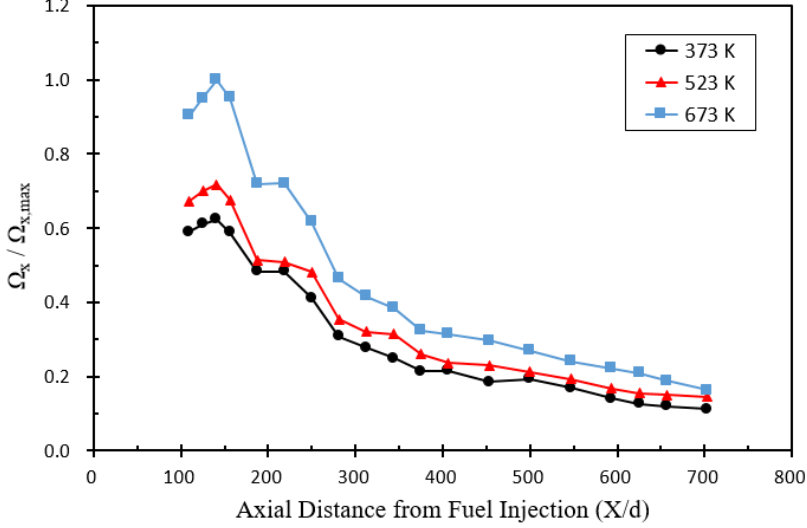
Figure 7. Streamwise vortex contours at various locations downstream of the pylon for an air temperature of 673 K.